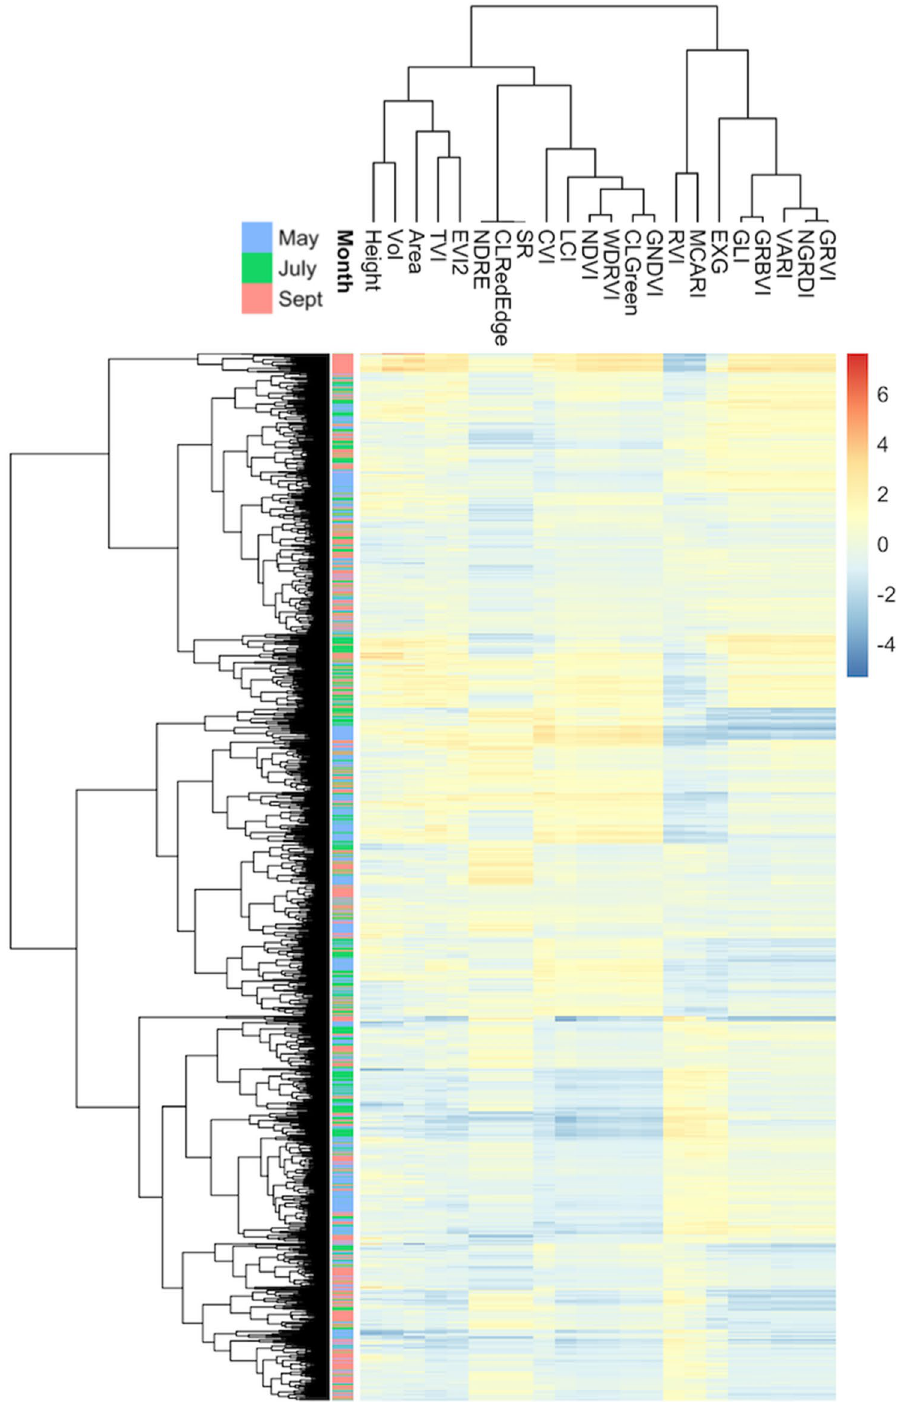
volume, and 19 vegetation indices defined in Table